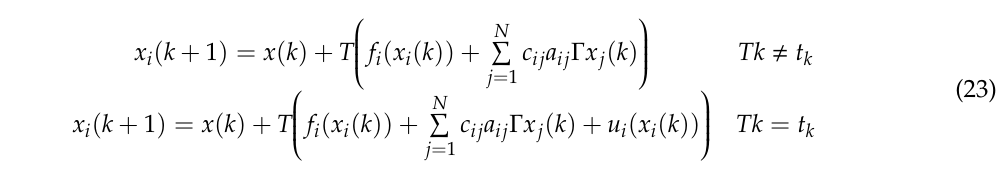
Figure 2. Node dynamics of the 20-node network with a single controller. From time 0 to 2 there are no connections between the nodes, after that, nodes are connected, at time = 4, control input is applied.